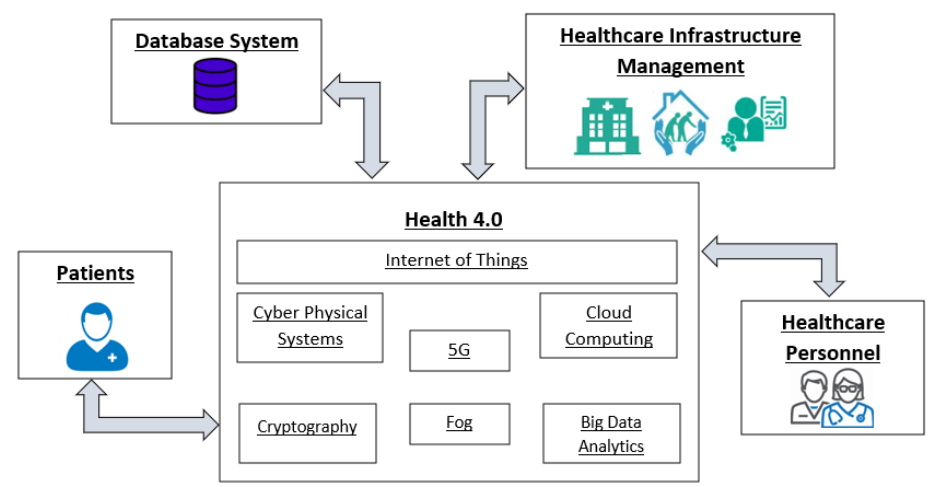
Figure 1. Health 4.0